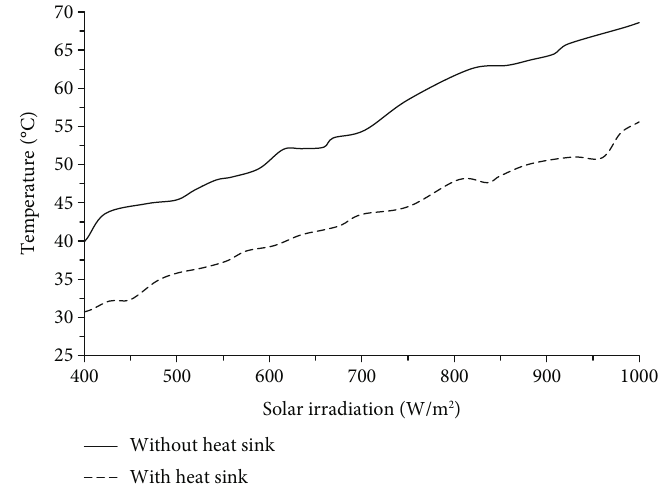
Figure 6: Average temperature of a PV panel under various solar irradiation.